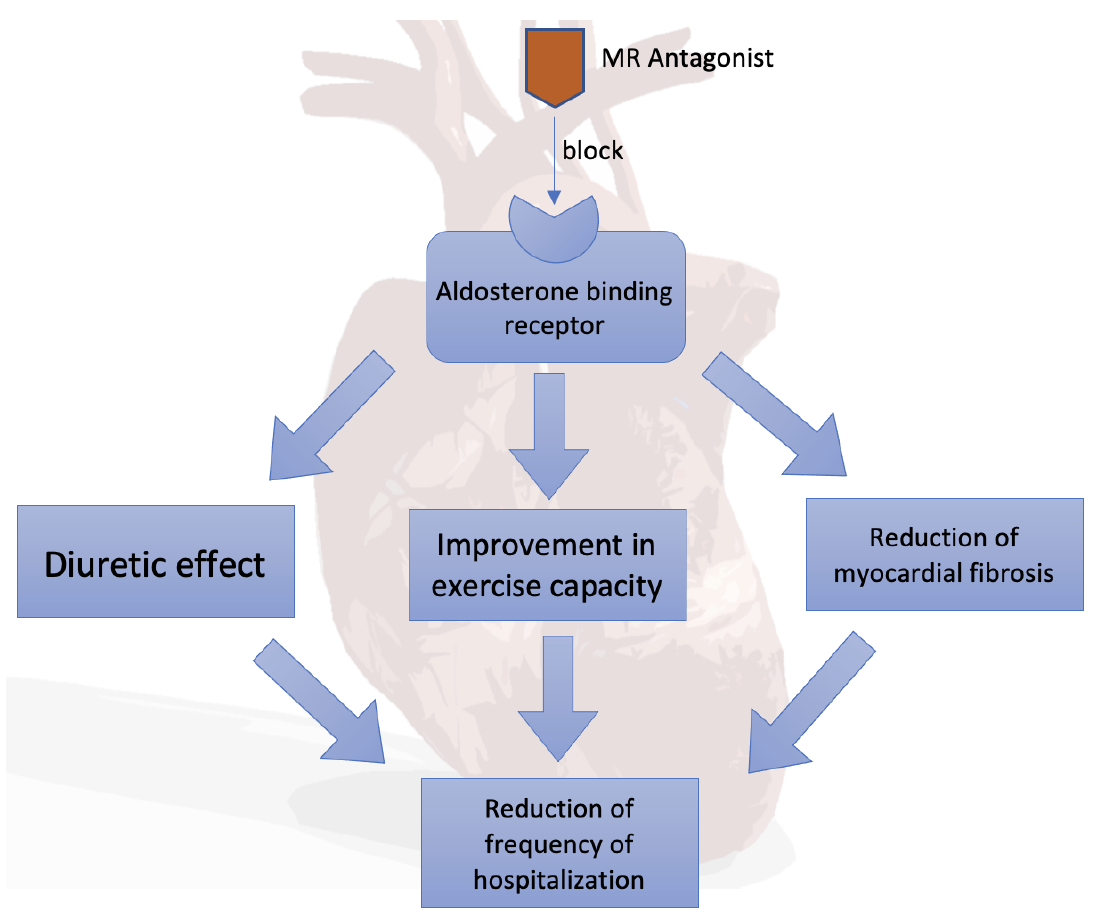
Figure 2. Mineralocorticoid receptor (MR) antagonists in heart failure.